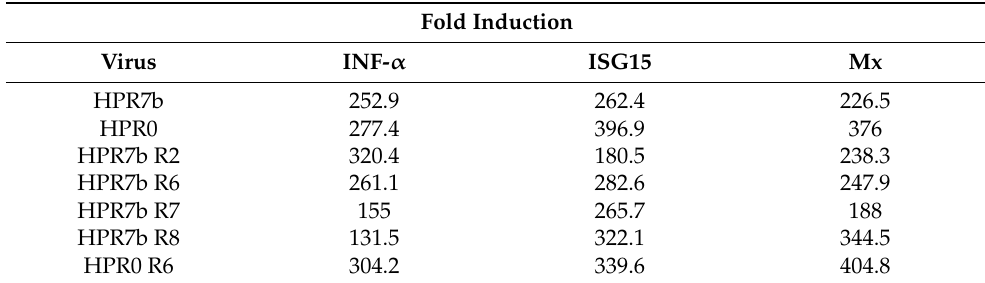
Table 4. Fold induction of IFN- α , Mx, and ISG15 genes at 72 hpi. ASK cells were infected, and an MOI of 0.1 and cellular RNA were extracted at 72 hpi. Gene expression was determined by qRT- PCR using the 18S ribosomal gene as the housekeeping gene.